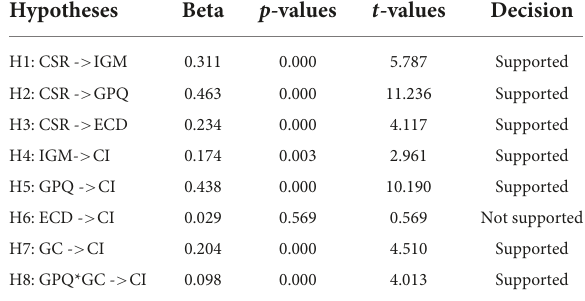
TABLE 6 Cross loadings.